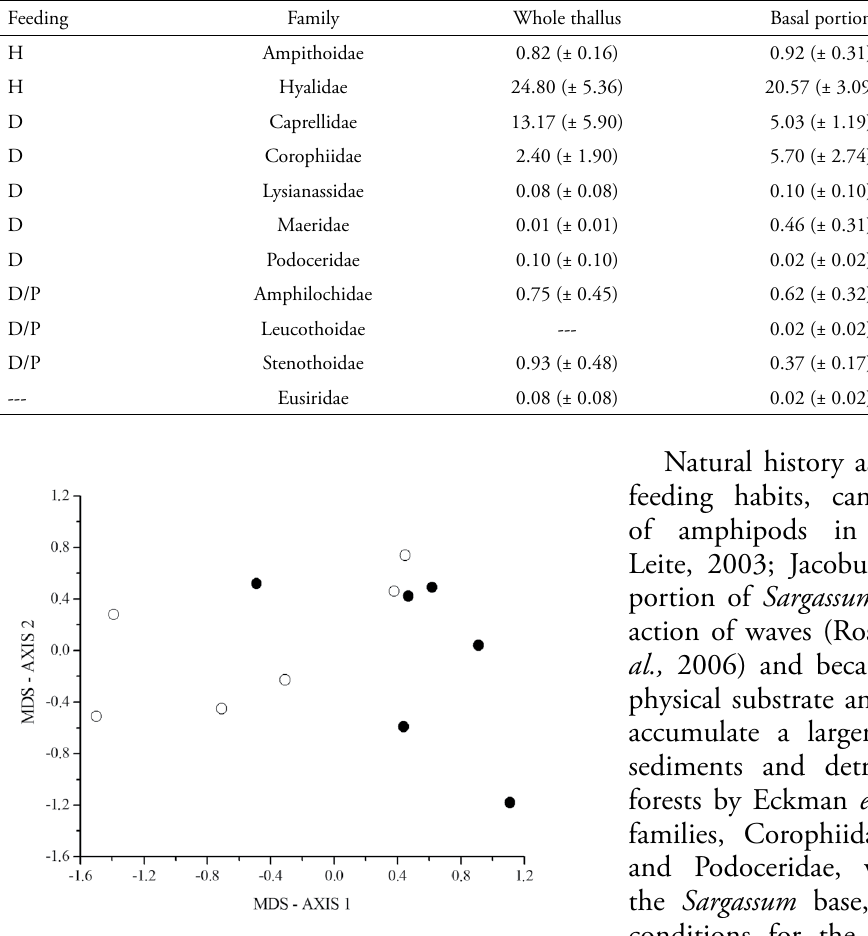
Figure 1. Non-Metric Multidimensional Scaling (nMDS) ordination of the composition of amphipod families associated to distal (solid circles) and basal (open circles) portions of Sargassum stenophyllum. Stress =